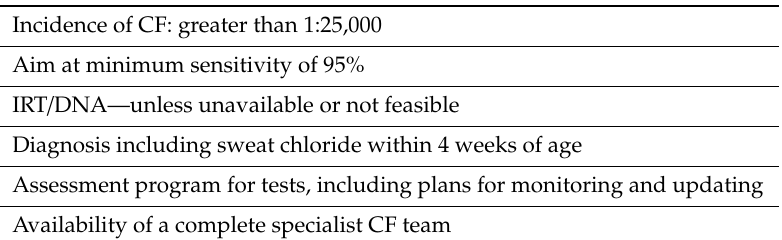
Table 3. Suggested criteria for cystic fibrosis newborn